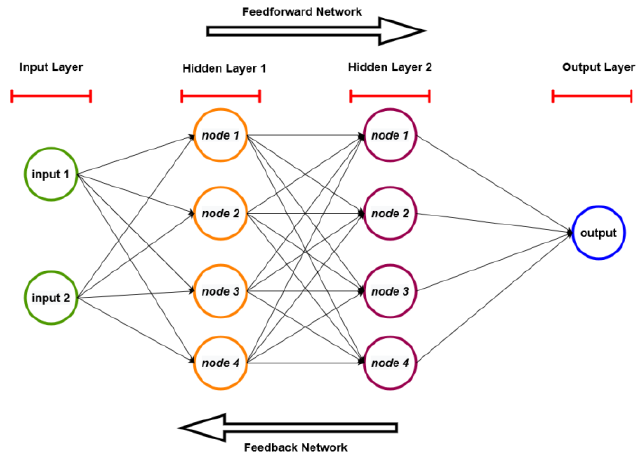
Figure 2. ANN Topology.